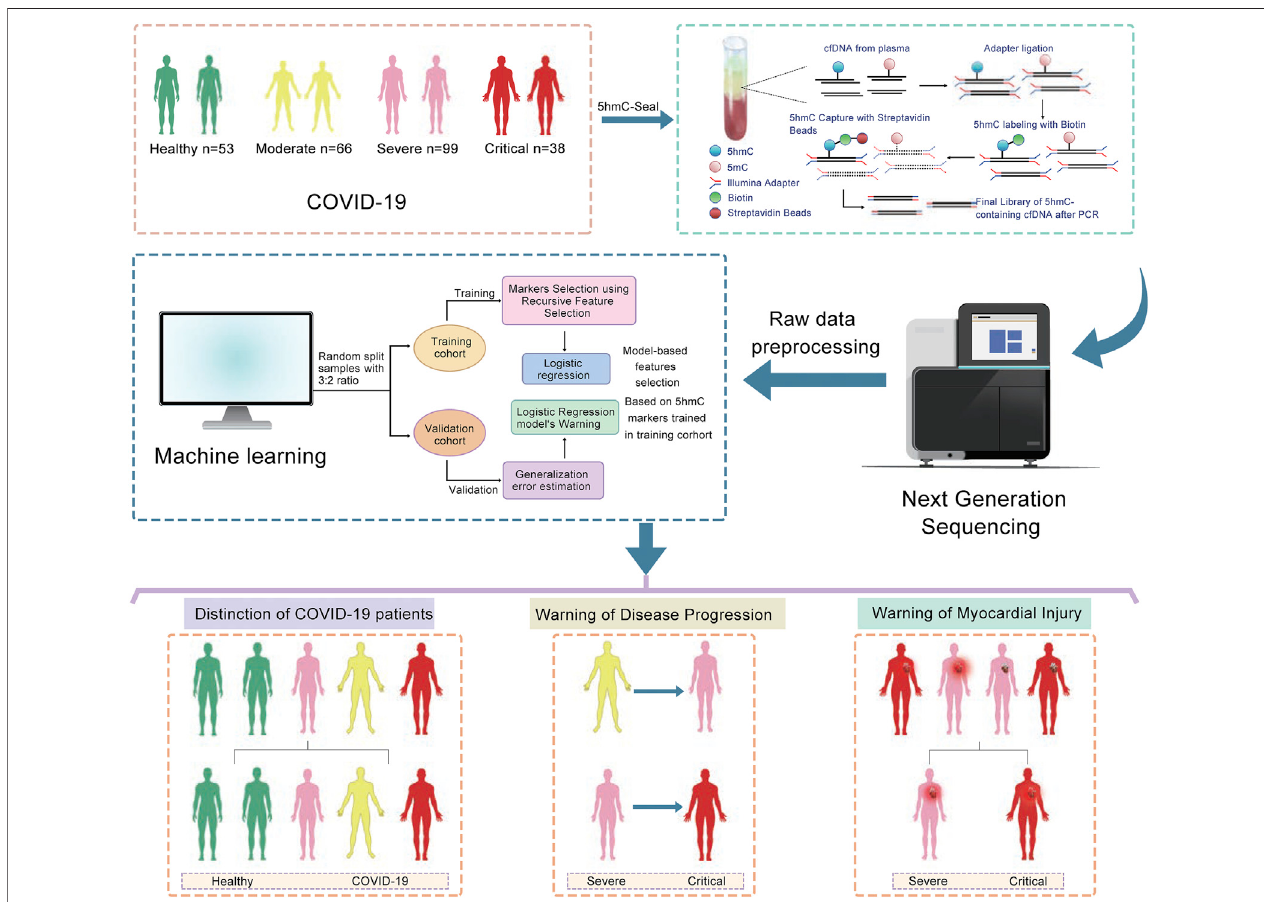
FIGURE 1 | Overview of study design. A total of 203 cfDNA samples were collected at the time of diagnosis from patients with COVID-19. 5hmC libraries for all samples were constructed with high-ef fi ciency hmC-Seal technology. cfDNA is ligated with Illumina adapter and labeled with biotin on 5hmC for pull-down with streptavidinbeads.The fi nallibraryiscompletedbydirectPCRfromstreptavidinbeads.Next,high-throughputsequencingwasperformedontheNextSeq500platform. A logistic regression model was trained by the training cohort was used to warn COVID-19 progression and myocardial injury in the validation cohort.